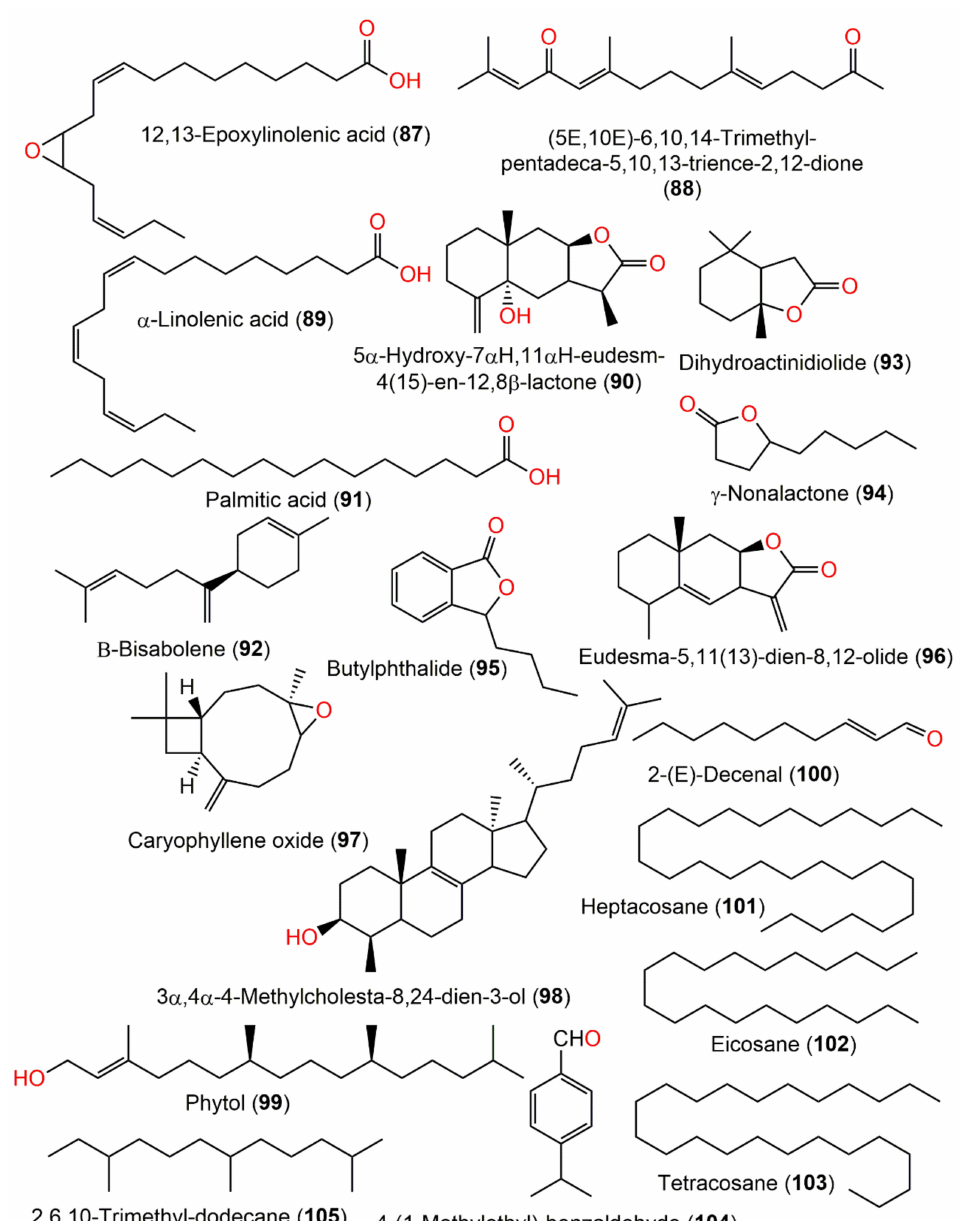
Figure 14. Structures of some volatile metabolites ( 87 – 105 ) reported from C. abrotanoides . In another study, GC/MS analysis of the essential oil of the whole plant collected from Hubei province, China, that was prepared by hydro-distillation (yield 0.39% w / w ) revealed the existence of sixteen compounds that represented 97.53% of the total oil, in- cluding eudesma-5,11(13)-dien-8,12-olide ( 96 ) (21.92%), caryophyllene oxide ( 97 , 13.01%), β - bisabolene ( 92 , 7.26%), 3 α ,4 α -4-methylcholesta-8,24-dien-3-ol ( 98 , 6.15%), phytol ( 99 , 5.57%), 2-( E )-decenal ( 100 , 5.56%), heptacosane ( 101 , 4.84%), eicosane ( 102 , 4.66%), tetracosane ( 103 , 4.56%), 4-(1-methylethyl)-benzaldehyde ( 104 , 4.52%), 2,6,10-trimethyl-dodecane ( 105 , 4.05%), torreyol ( 106 , 3.82%), androst-5,7-dien-3-ol-17-one ( 107 , 3.24%), β -cedrene ( 108 , 2.83%), α -curcumene ( 109 ), and 2,6,10-trimethyl-tetradecane (3.15%, 110 ) (2.43%) [15]. On the other side, the fresh aerial parts of C. abrotanoides collected from the Abbottabad, Pak- istan, yielded 0.04% essential oil. Its GC/MS analysis displayed 39 compounds, including caryophyllene ( 111 , 24%), trans -nerolidol ( 112 , 2%), geranyl isobutyrate ( 113 , 10.63%), δ -cadinene ( 114 , 8.83%), β -eudesmene ( 115 , 4.67%), caryophyllene oxide ( 97 , 3.89%), trans